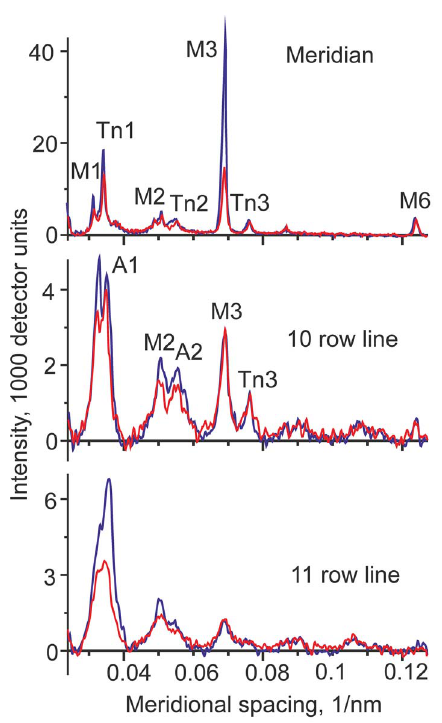
meridional intensities during isometric contraction (blue lines) and ramp stretch (red lines) in the 1 st series of experiments. The intensities were integrated in the reciprocal radii regions of 6 0.018 nm 2 1 (meridian), 0.018–0.035 nm 2 1 (10 row line), and 0.035– 0.06 nm 2 1 (11 row line) after correction for the change in specimen volume in the x-ray beam and mirroring four quadrants of the x-ray diffraction pattern. Background was subtracted as described [11,14]. The positions of some X-ray reflections of interest are marked.